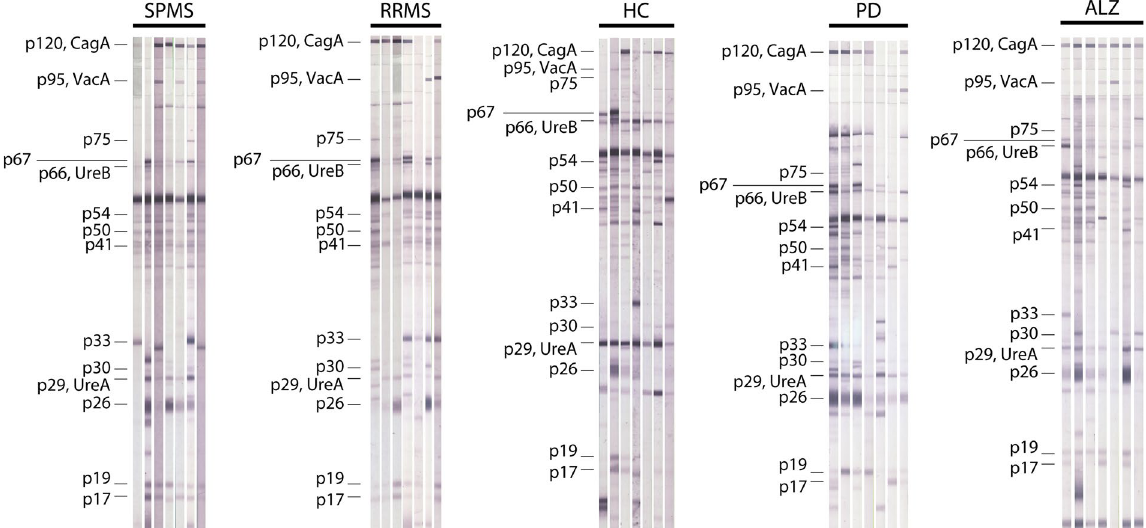
Figure 1. Antibody reactivity against H . pylori antigens by Western immunoblotting in representative RRMS (n = 7) patients, SPMS (n = 7) patients, healthy controls (HC) (n = 7), patients with Parkinson’s disease (PD) (n = 7) and patients with Alzheimer’s disease (ALZ) (n = 7). Abbreviations: CagA, protein from cytotoxin- associated gene A; UreA, urease A; UreB, urease B; VacA, vacuolating cytotoxin A.